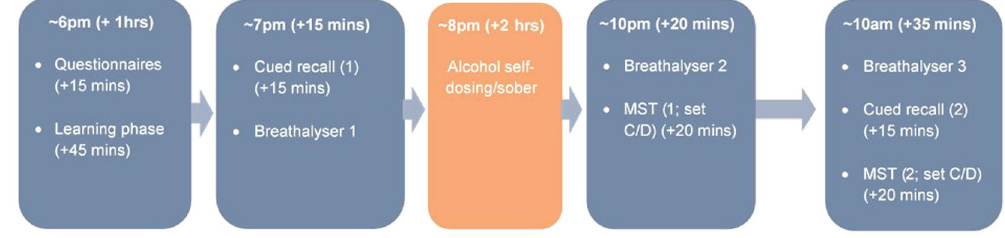
Figure 2. Schematic illustration of the sequence of memory tasks participants underwent during each session, accompanied by approximate